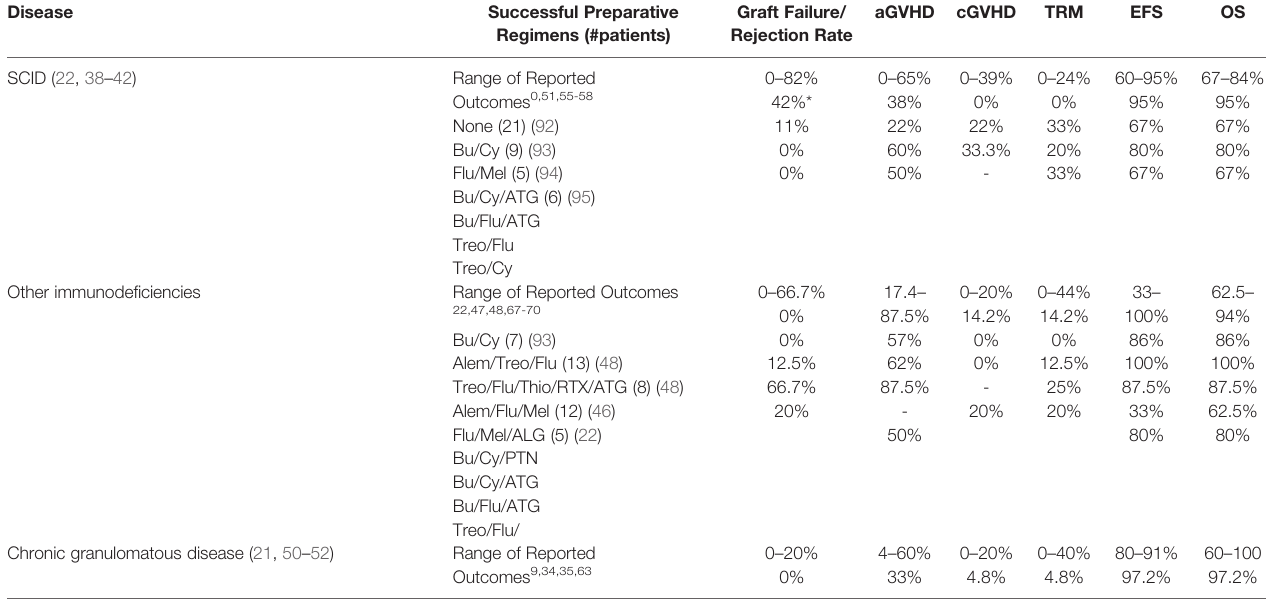
TABLE 2 | Variation of HSCT outcomes.